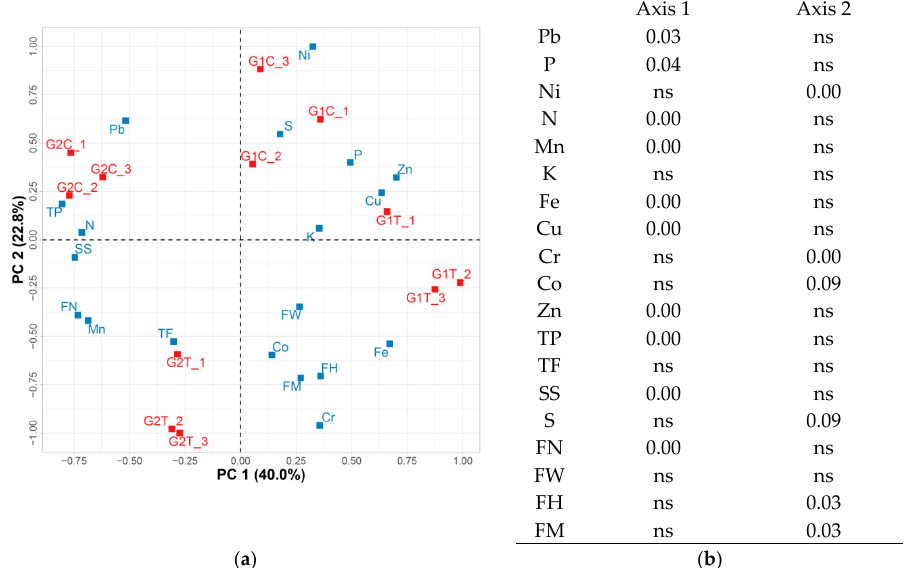
Figure 3. ( a ) PCA analysis of Narvik (G1) and Gružanski zlatni (G2) tomato cultivars, grown in the polytunnel without (C) or with T. harzianum application (T), involving: fruit weight (FW (cm 10 − 2 )), fruit height (FH (cm 10 − 2 )), number of fruit per plant (FN), fruit mass (FM (g)), total polyphenols (TP (GEA mg/100 gDW)), total flavonoids (TF (mg/100 gDW)), starch (S (mg/g DW)), contents of soluble sugars (SS (mg/g DW)), macroelements N (%), P (ppm), K (ppm) and heavy metals (ppm): Mn, Fe, Cu, Zn, Ni, Cr, Pb, and Co. ( b ) Correlation matrix (Pearson´s product correlation coefficient) with the associated p value between the principal components and the analyzed variables.